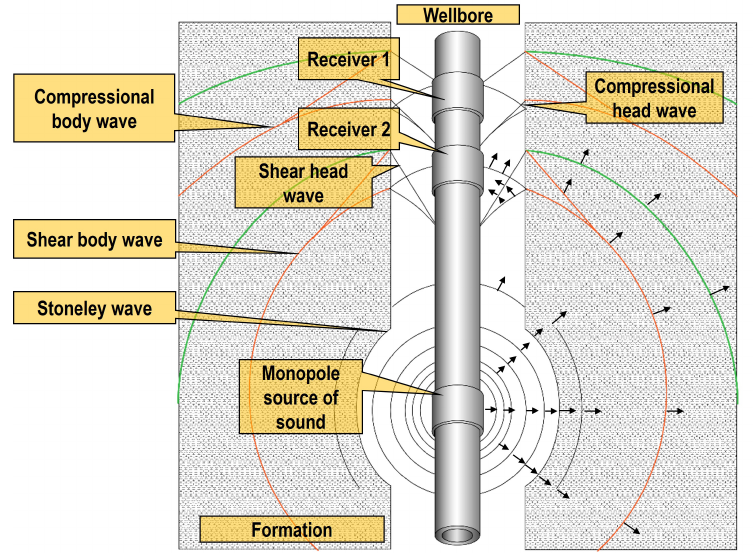
Figure 11. Waves traveling in the case of a monopole source of